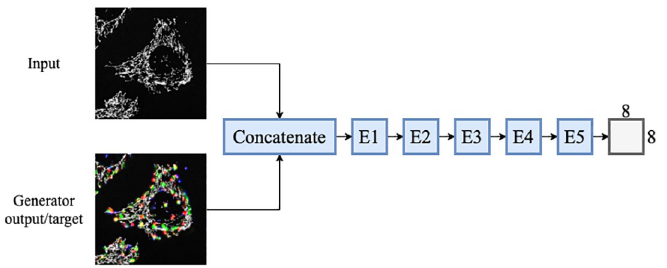
Fig 5. The discriminator architecture of the three-dimensional Pix2Pix GAN. The discriminator receives and concatenates both the input frame and the generator output/target z-stack as input.